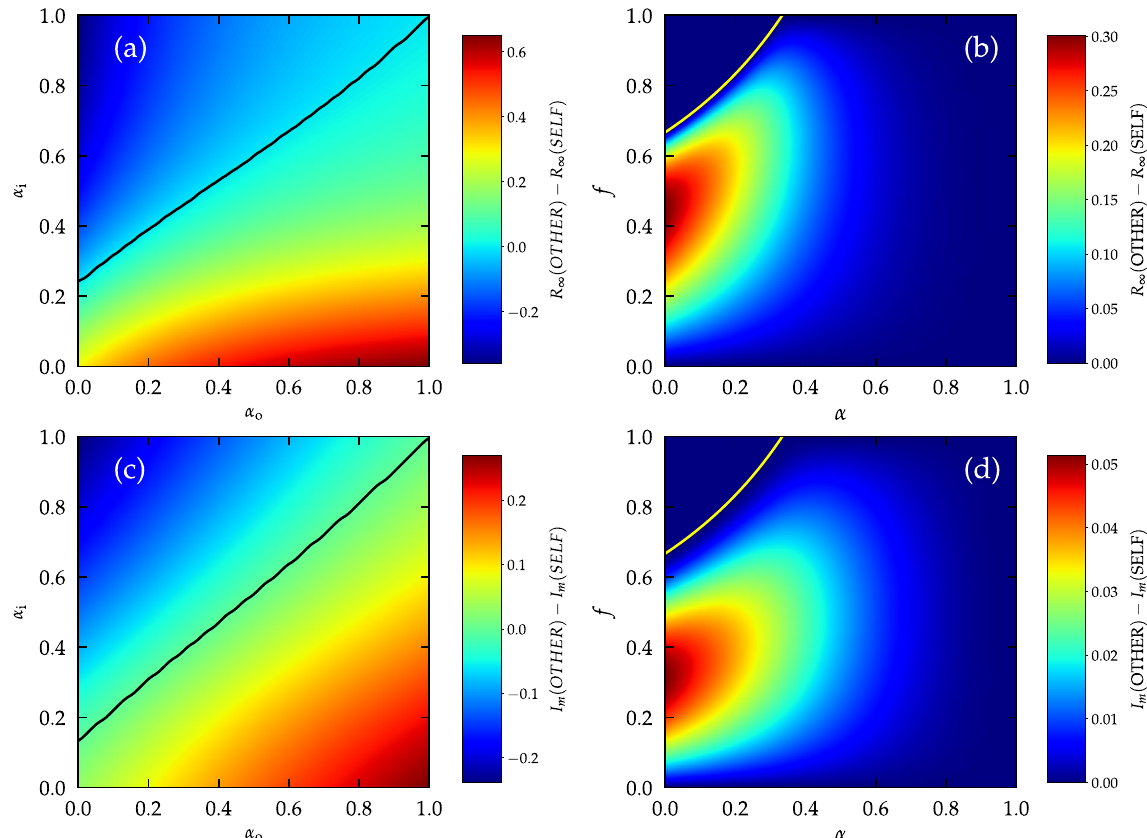
Figure 1. SELF interventions are more effective than OTHER interventions at the population level. ( a ) Difference between the final prevalence R ∞ for the OTHER and the SELF scenario ( R ∞ ( OTHER ) − R ∞ ( SELF ) ), as a function of α i and α o of the individual PI. Notice that R ∞ ( OTHER ) depends only on α o , and R ∞ ( SELF ) depends only on α i . The solid black line indicates the zero value. ( b ) Difference between the final prevalence R ∞ for the OTHER and the SELF scenario as a function of the fraction f of adopters and the efficacy α of the individual PI. The solid yellow line denotes where (cid:31) c (α) = (cid:31) . Above it, the system is subcritical and R ∞ ( OTHER ) − R ∞ ( SELF ) = 0 . ( c ) Difference between the maximum value of the incidence I m for the OTHER and the SELF scenario ( I m ( OTHER ) − I m ( SELF ) ), as a function of α i and α o of the individual PI. Notice that I m ( OTHER ) depends only on α o , and I m ( SELF ) depends only on α i . The solid black line indicates the zero value. ( d ) Difference between the maximum value of the incidence I m for the OTHER and the SELF scenario as a function of the fraction f of adopters and the efficacy α of the individual PI. The solid yellow line denotes where (cid:31) c (α) = (cid:31) . In all plots quantities greater than zero indicate that SELF interventions perform better. Solution of homogeneous MF equations for a network of degree K = 7 and for (cid:31) = 0.5 . In panels ( a ) and ( c ) f = 0.5 . For these parameters, in panels ( a ) and ( c ) both SELF and OTHER strategies operate above their respective